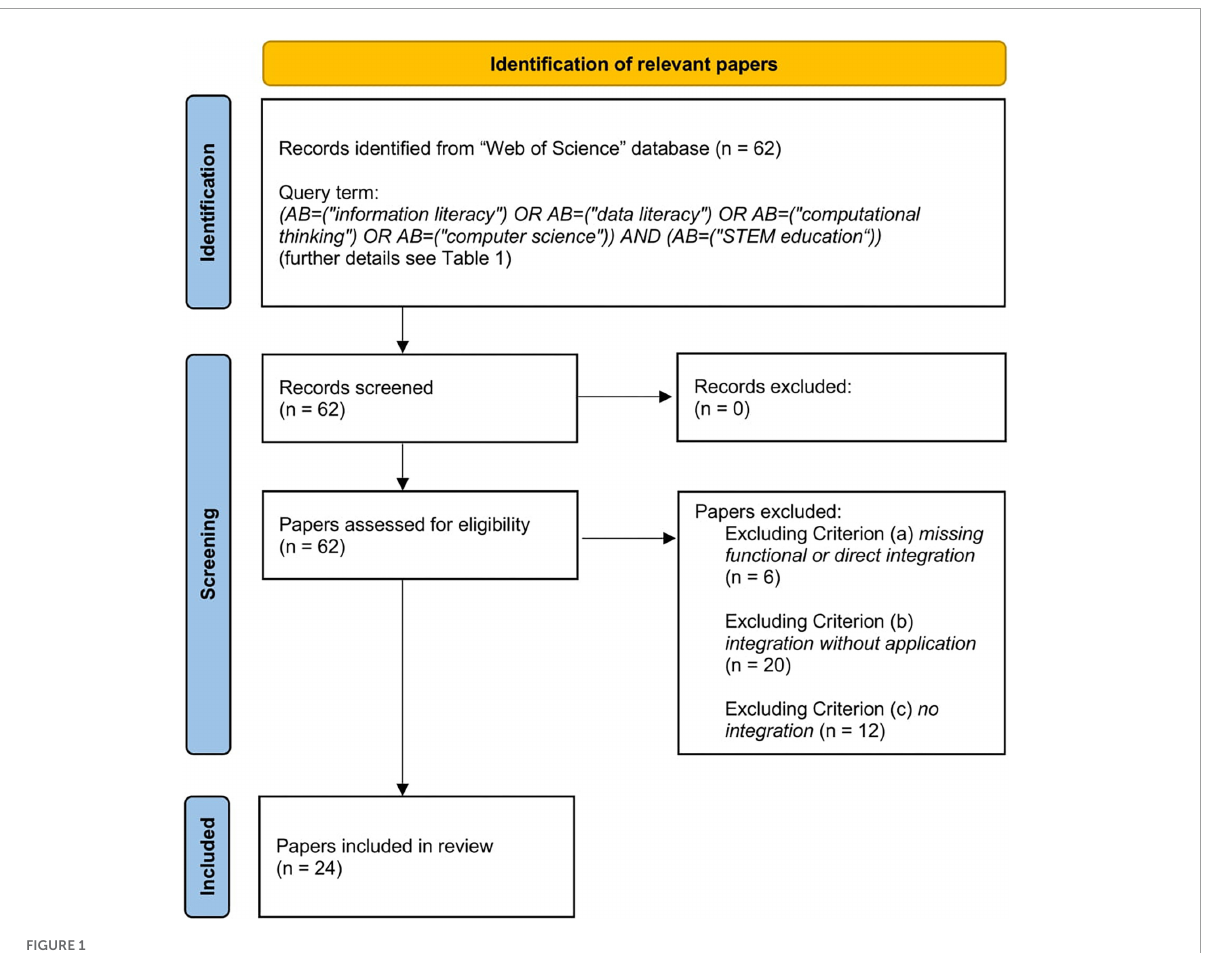
FIGURE1 PRISMA flow